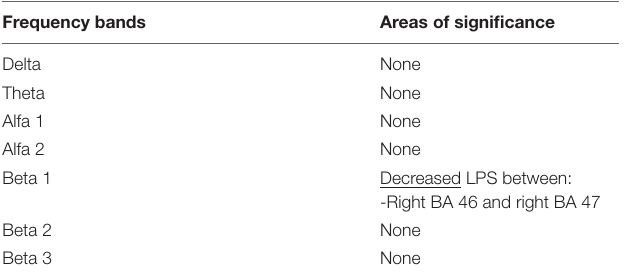
TABLE 4 | Changes in “lagged phase synchronization” in pHD subjects following correlation with SDMT (correct answers item) in all frequency bands and the involved